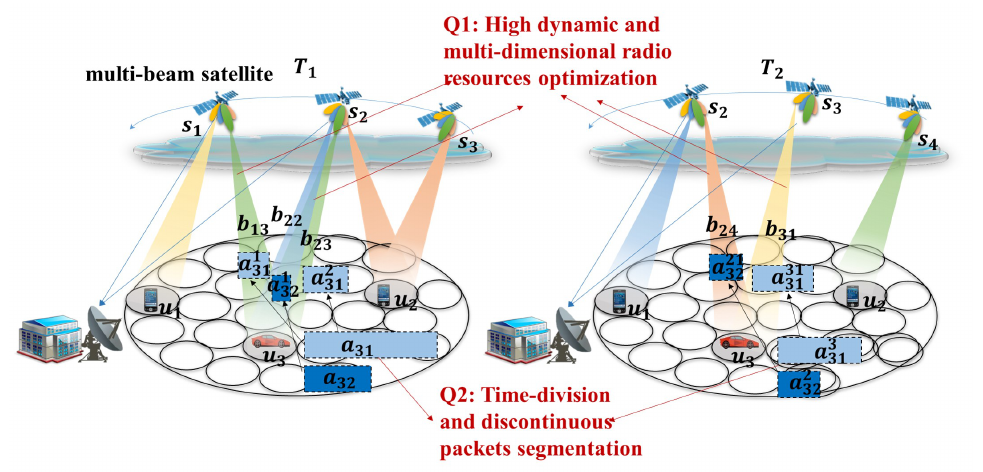
Figure 1. Model of multi-beam satellite communication system. According to the options in the 3GPP, a four-color multiplexing scheme is used between beams. Spectrum is shared between satellites. The protocol between satellites and users includes control plane protocol and user plane protocol, which processes the data packets with different delays, different QoS requirements, and different sizes generated by users. Physical signals between satellites and users are processed by Low Density Parity Check Code (LDPC) and Quadrature Phase Shift Keying (QPSK). Channel multiplexing is realized by